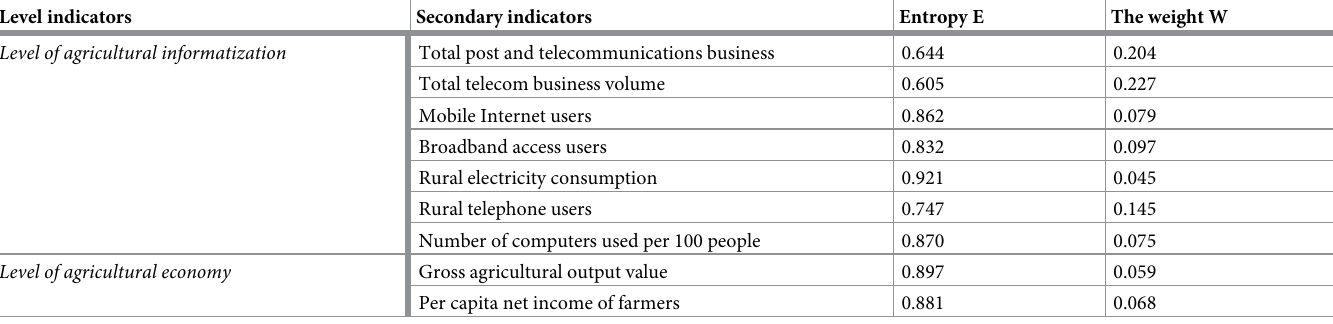
Table 6. Determination of the weight of evaluation